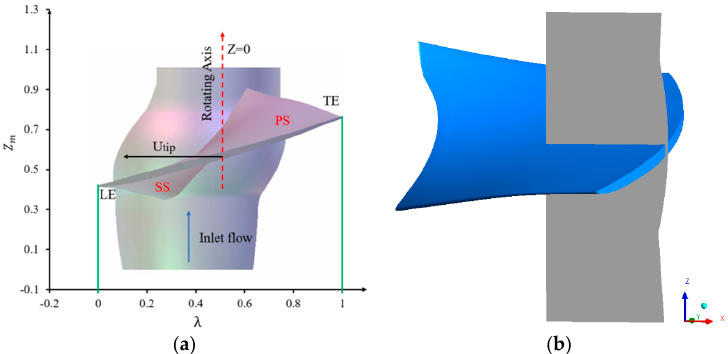
Figure 17. Parameter definition of the blade tip: ( a ) impeller’s blade; and ( b ) selected plane at λ = 0.4.